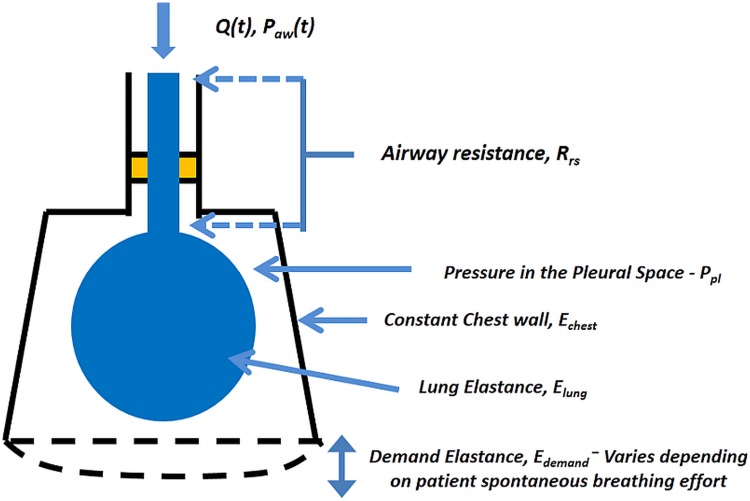
The measured airway pressure consists of 4 pressure components: 1) Pressure drop due to airway resistance (Prs); 2) pressure in the lung compartments (Plung(t) = Elung(t) ×V(t)); 3) A constant chest wall pressure, Pchest = Echest(t)×V(t); and 4) Demand pressure, Pdemand = Edemand(t)×V(t).